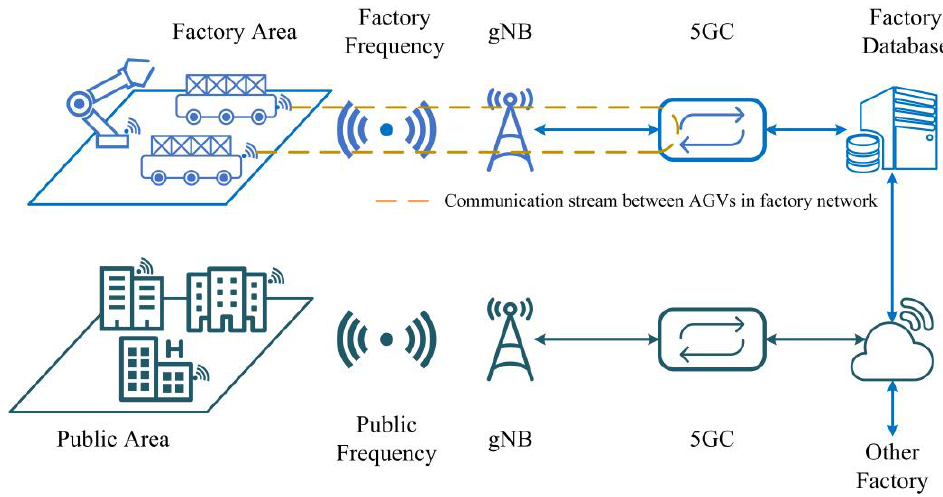
Figure 1. Structure of 5G physical private